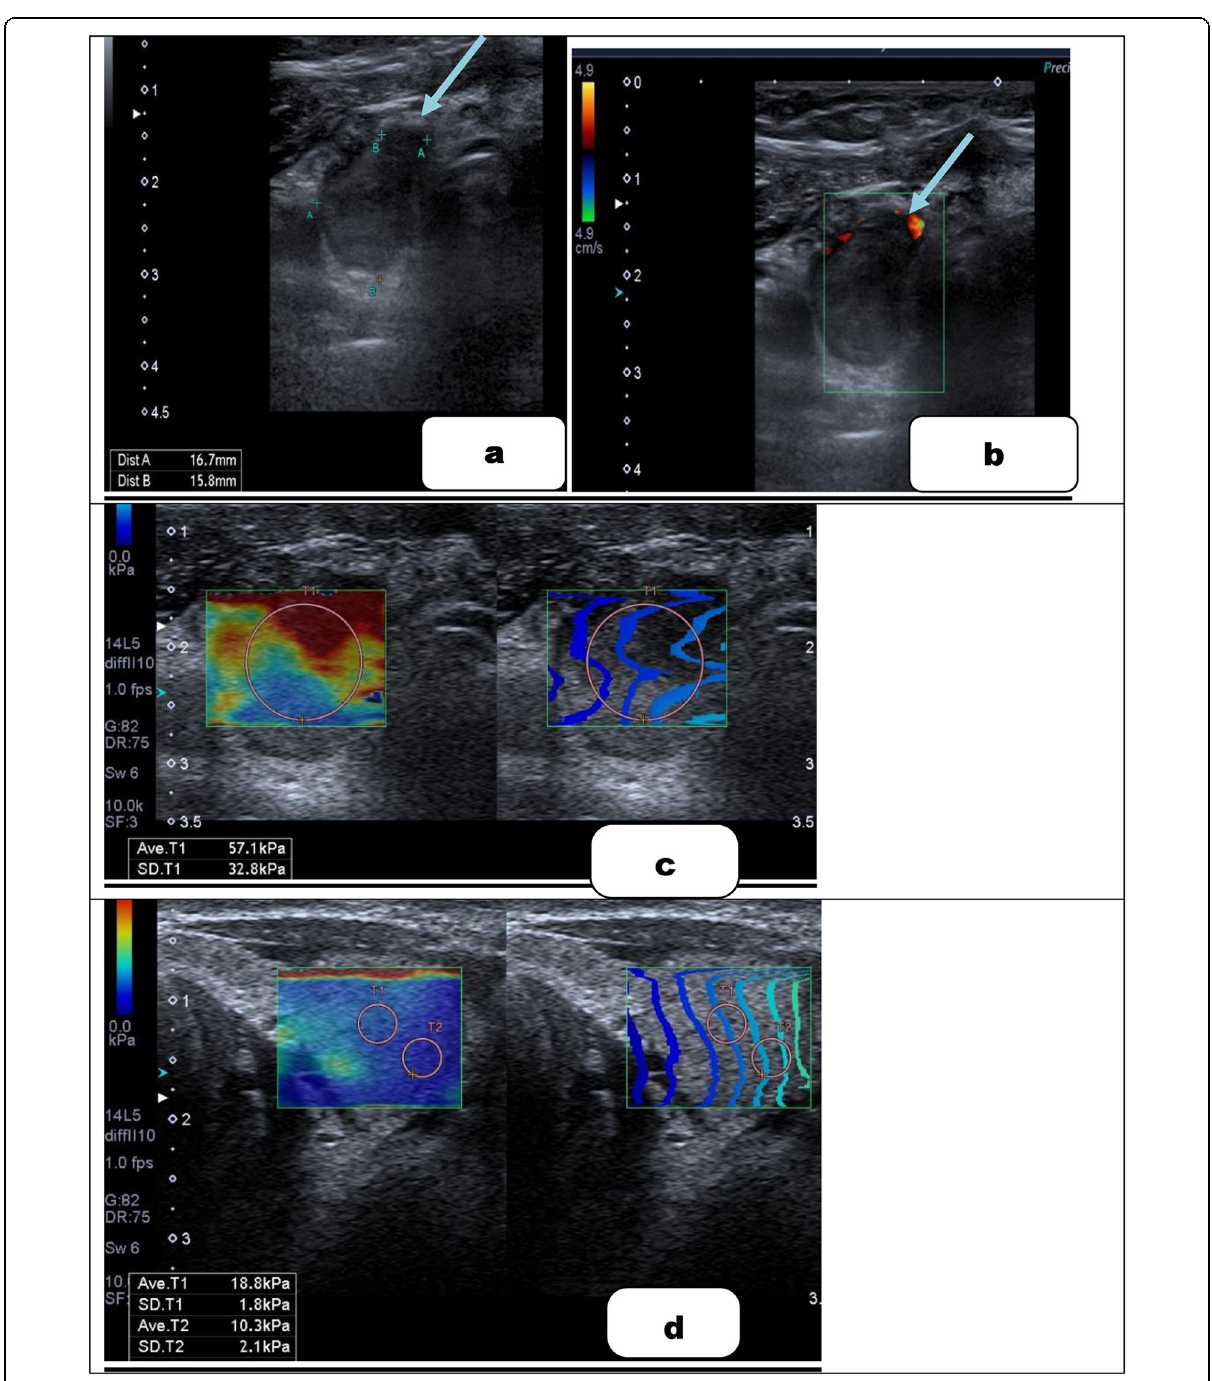
Fig. 5 Ultrasound images for a 60-year-old female patient. a Axial ultrasound B-mode image is showing a right solid hypoechoic thyroid nodule with an irregular margin and peripheral calcification (TI-RADS 5) (arrow). b Axial color image is showing peripheral vascularity (1a) (arrow). c Axial SWE of the thyroid nodule ( E mean = 57.0 kPa and ER = 3). d Axial SWE of normal left thyroid parenchyma; the FNAC revealed malignant cells with psammoma bodies (Bethesda 5), and the post right hemithyroidectomy histopathology had confirmed the diagnosis of